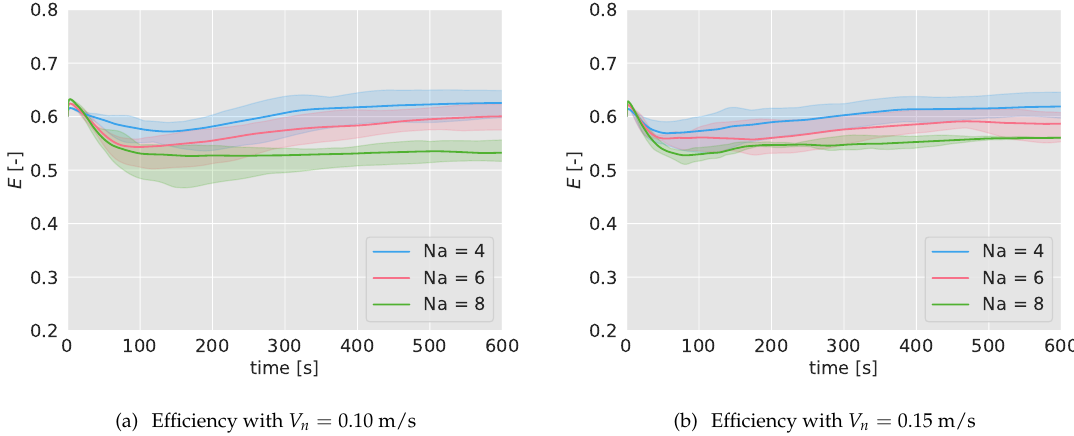
Figure 5. Surveillance mean efficiency, calculated from 5 simulations, during the mission with different number of drones, N a = 4,6,8. In ( a ) with a nominal speed of 0.10 m/s; in ( b ), for 0.15 m/s. The colored bands indicate the range within the efficiency lies for the 5 simulations carried